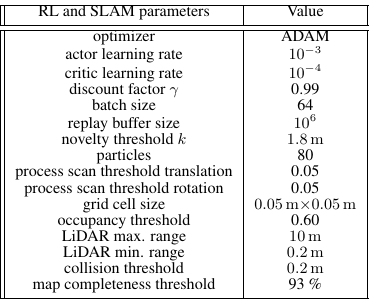
Table 2. Parameters of the